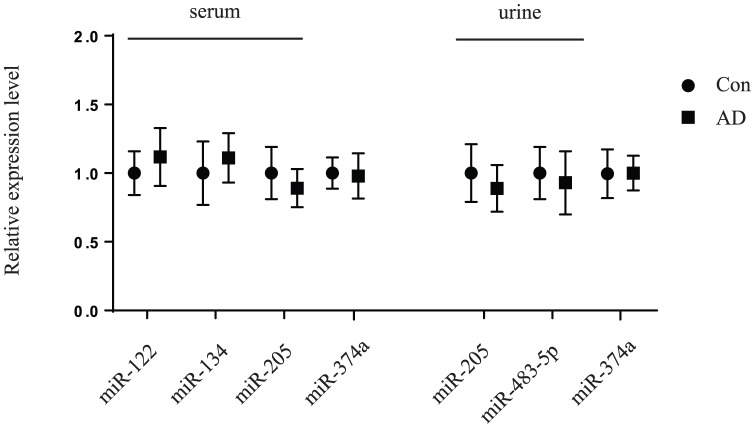
Validation of other miRNA expression levels by quantitative real-time PCR.Selected miRNAs (miR-122, miR-134, miR-205 in serum and miR-205, miR-483-5p in urine) were measured in 30 children with AD and 28 healthy children. The 2−△△CT method in one subject with children with AD was normalized to 1. miR-374a expression levels in serum and in urine were considered as control. Data are presented as mean values (± SD).